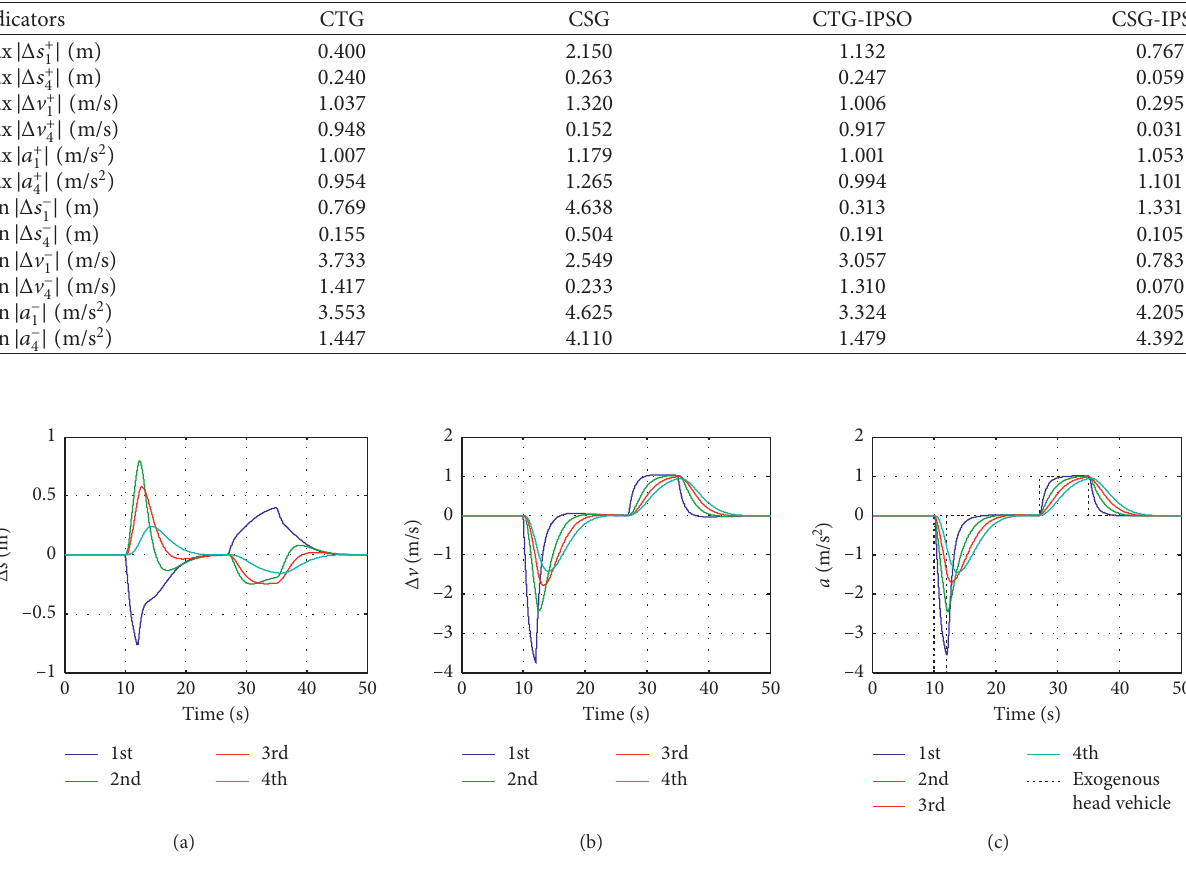
Figure 4: Simulation result of CTG: (a) gap error, (b) relative speed, and (c)